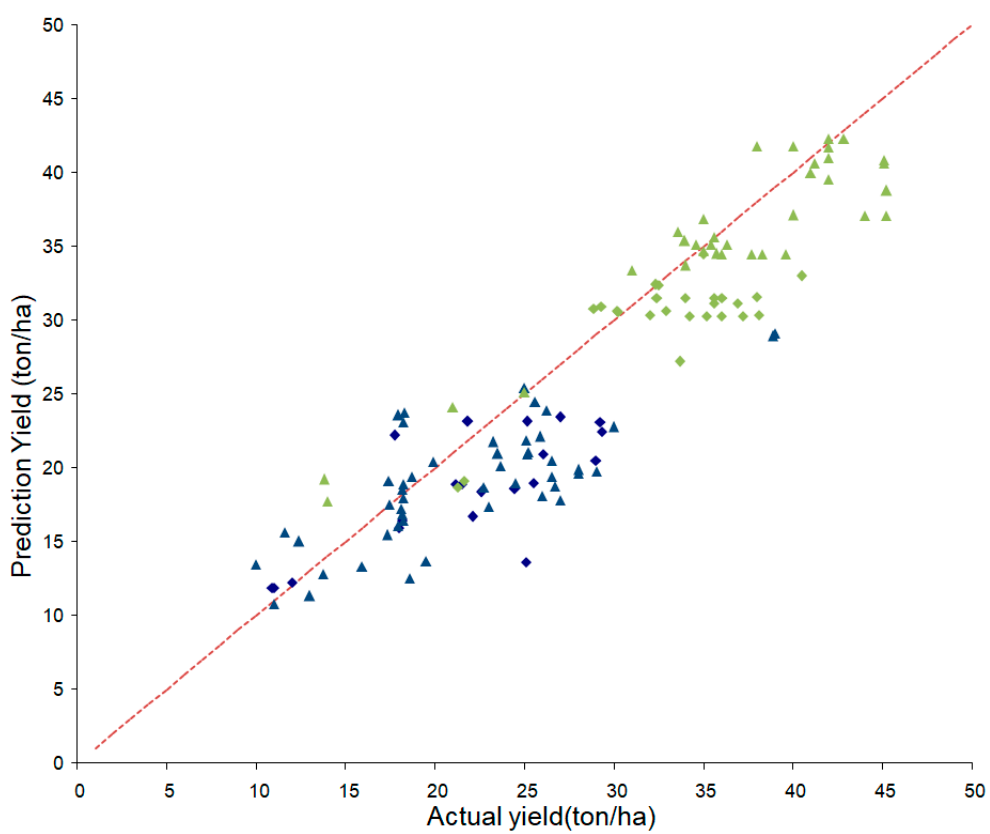
Figure 5. Comparison between predicted and actual yields in the independent dataset (2017–2018). Navy blue color represents rain-fed crops, green color represents irrigated crops, diamond-shaped objects represent prediction and actual yield for the rf model (3-month scenario, winter cycle) and triangle-shape objects represent prediction and actual yield for the svmP model (5-month scenario, summer cycle).